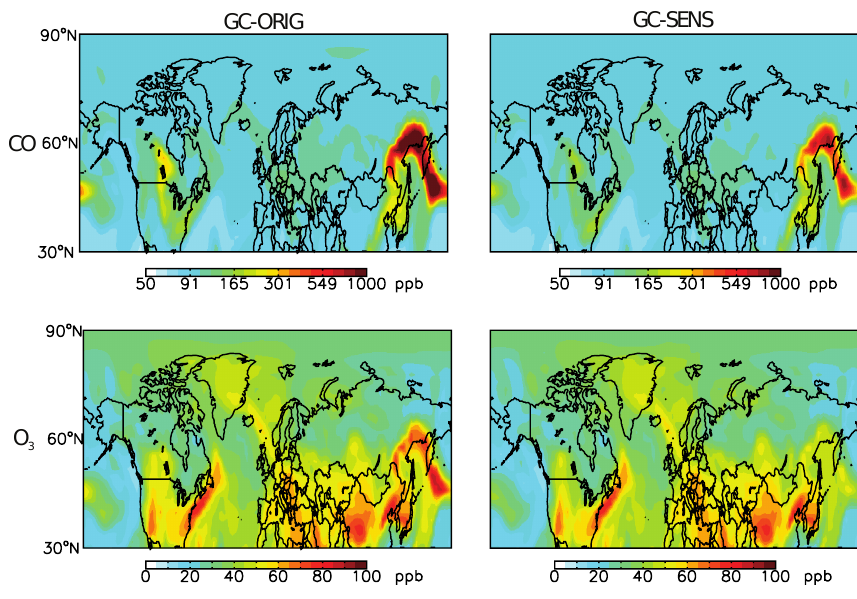
Fig. 7. Mixing ratios of CO and ozone at 850hPa in the original GEOS-Chem simulation (GC-ORIG) and in the emissions sensitivity case (GC-SENS) for 4 July 2008. Note that the different emissions started on 15 June